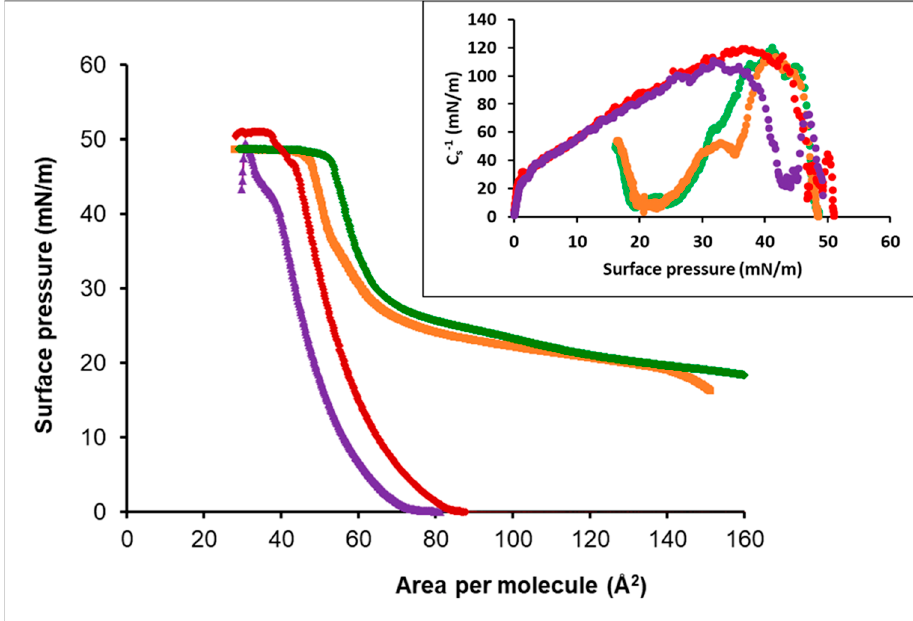
Figure 8. Surface pressure-area isotherms and elastic modulus curves (inset) for OA-POPC mix- tures: X OA = 0.402, in the absence (violet) and in the presence (orange) of lysozyme; X OA = 0.230, in the absence (red) and in the presence (green) of lysozyme.